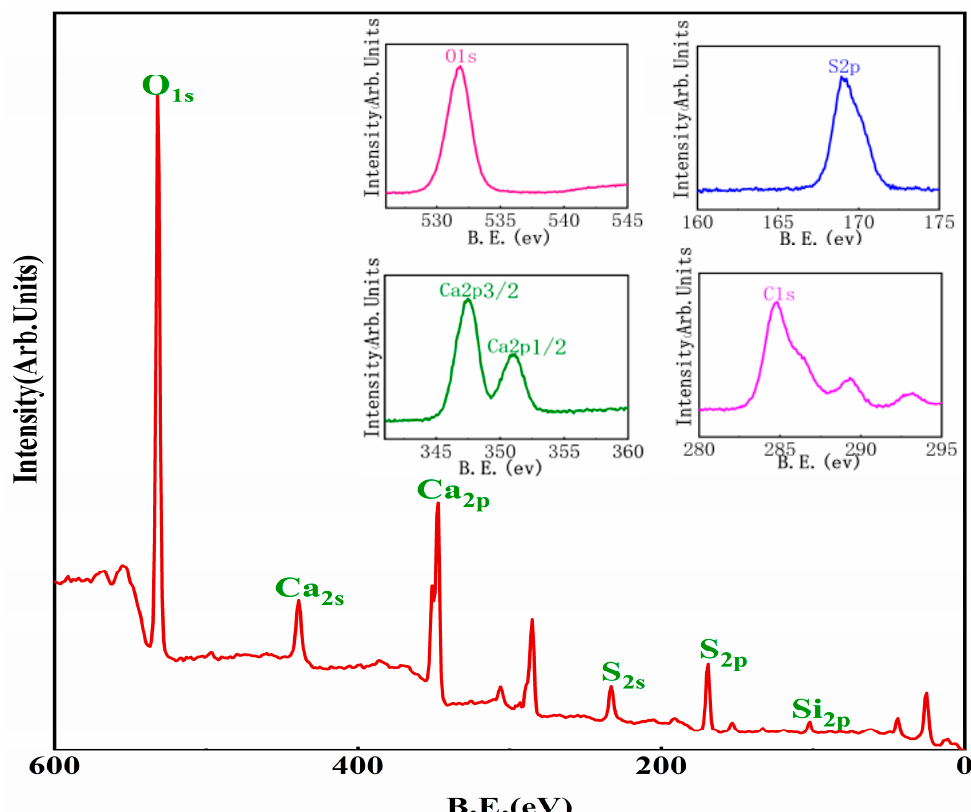
Figure 5. XPS spectra of HPG-E 50 (the inset is high-resolution spectra of O1s, S2p, Ca2p 1/2 , and C1s, respectively).